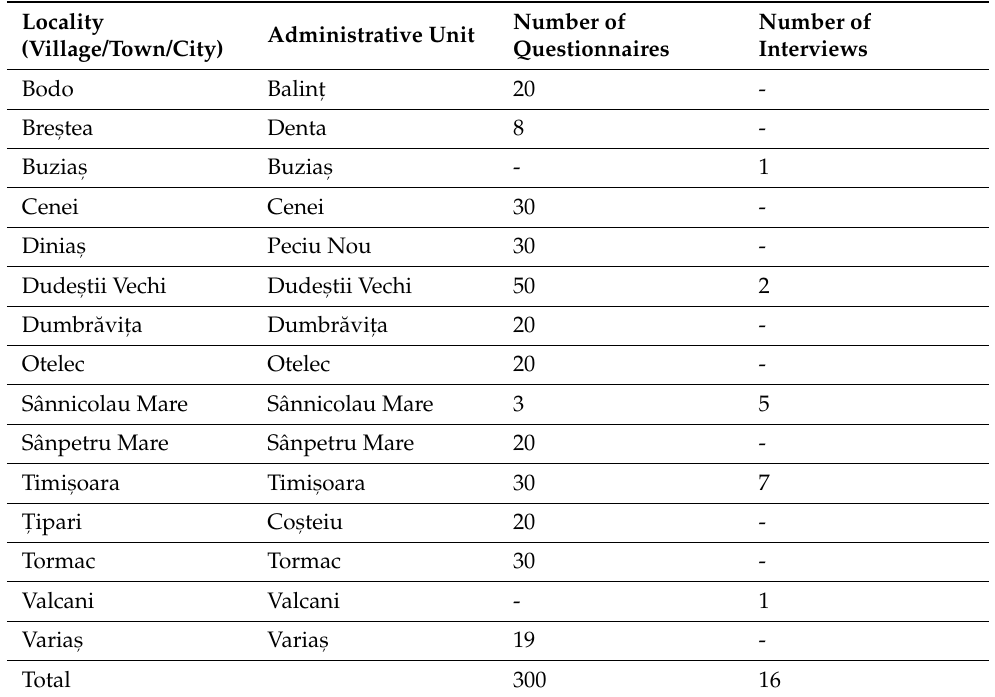
Table 1. Number of questionnaires and interviews applied in Timis